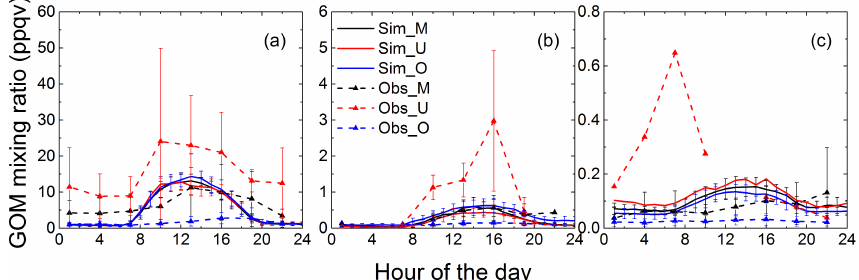
Figure 4. Observed (dash line with scatters) and simulated (solid line) average diurnal cycles of GOM for the matching (black, “Sim_M” and “Obs_M”), underestimation (red, “Sim_U” and “Obs_U”), and overestimation cases (blue, “Sim_O” and “Obs_O”) at AI (a) , TF (b) , and PM (c) . The bars represent the standard deviations at each hour for those specific